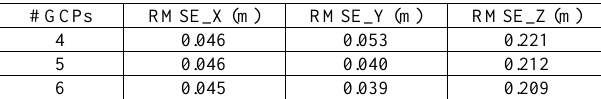
Table 5. Simulated data: discrepancies in seven checkpoints using 4 bands and 28 GCPs.